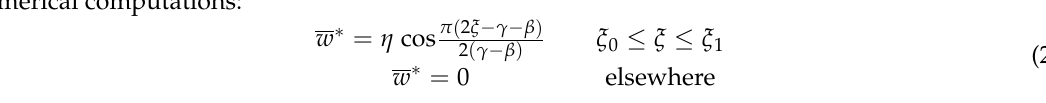
Figure 3. Various imperfection types considered in numerical results.